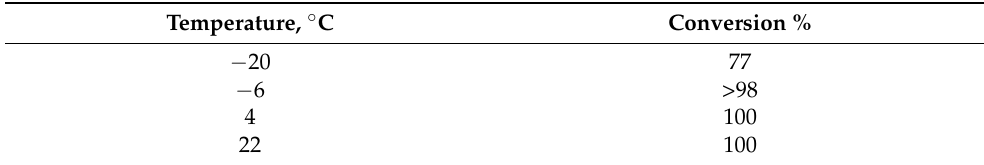
Table 2. The effect of the reaction temperature (4 h) in MeCN on the conversion of the starting chalcone 3 in the presence of bispidinone 42 .